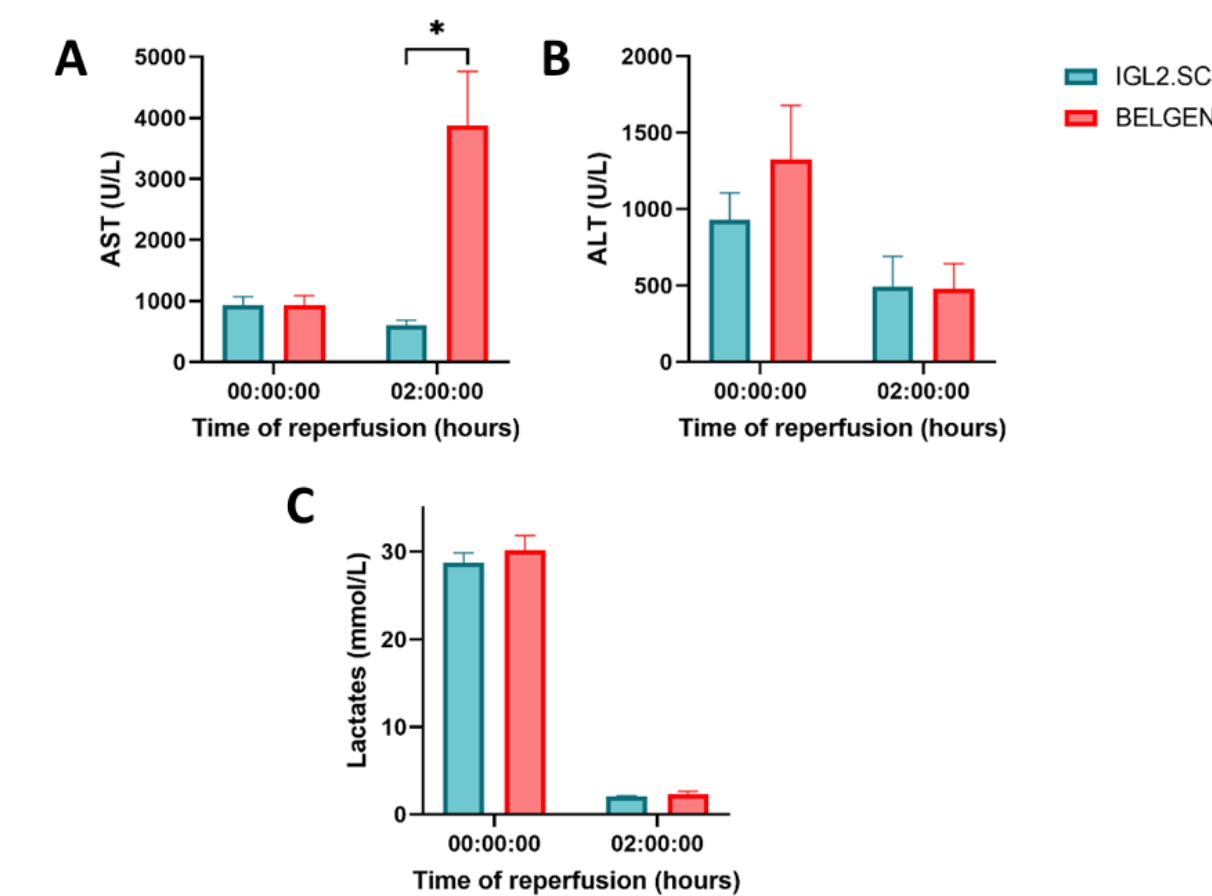
Figure 2. Hepatocellular injury markers quantification and anaerobic state evaluation. ( A ) Aspartate aminotransferase (AST) was significantly lower in the IGL2 group than in the BELGEN group after 2 h of reperfusion ( p < 0.01). ( B ) Alanine aminotransferase (ALT) expression tended to be decreased in the IGL2 group compared to the BELGEN group after 2 h of reperfusion ( p = 0.95). ( C ) No differences were observed in the lactate levels between the two groups. n = 6/group. * = p < 0.05.